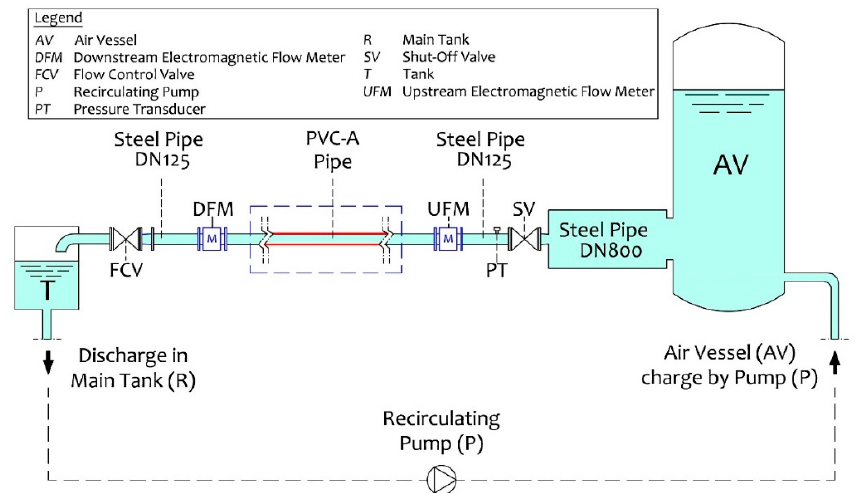
Figure 2. Layout of the experimental setup at the Laboratory of Hydraulics (University of Naples Federico II).